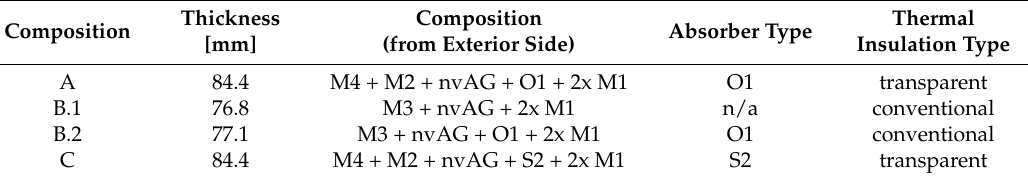
Table 3. Table of measured